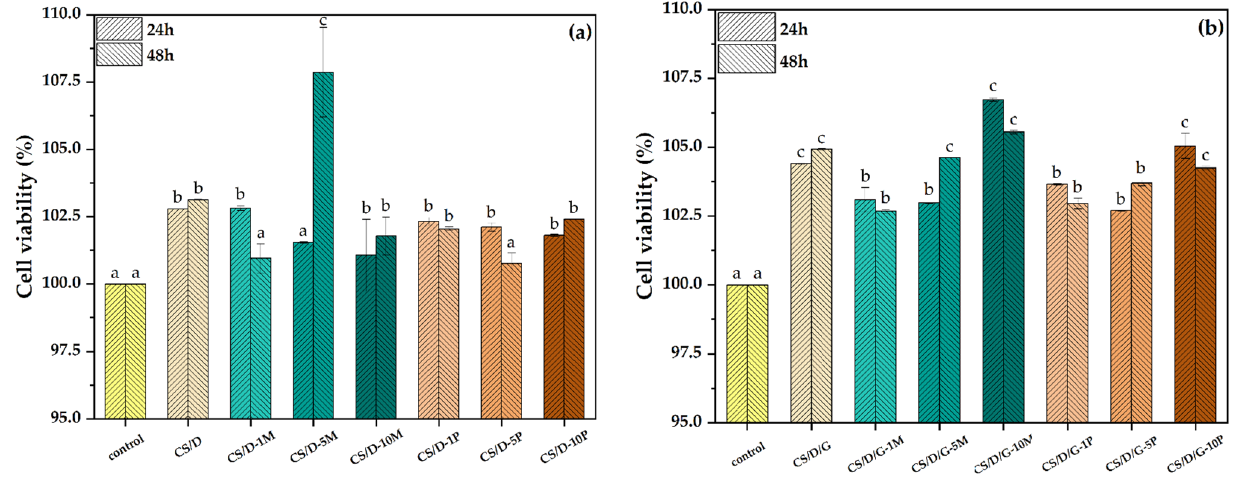
Figure 10. Cell viability for the CS/D ( a ) and CS/D/G ( b ) hydrogels (* p value < 0.03; different letters indicate levels of significance between each sample).